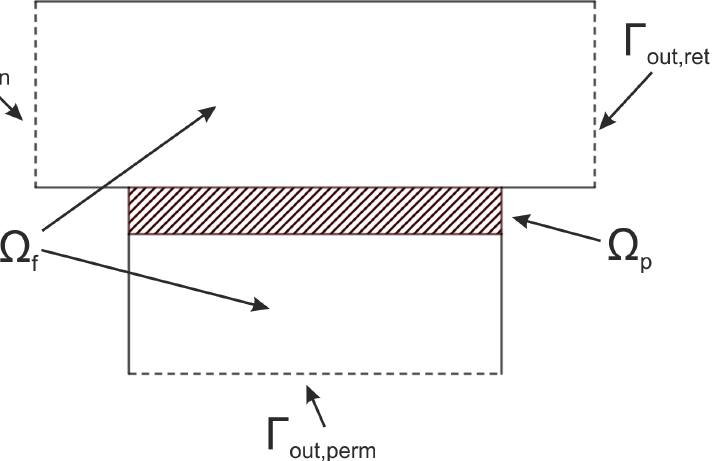
Figure 1. A schematic view of a vertical cross-section of the computational domain. The hatched part depicts the